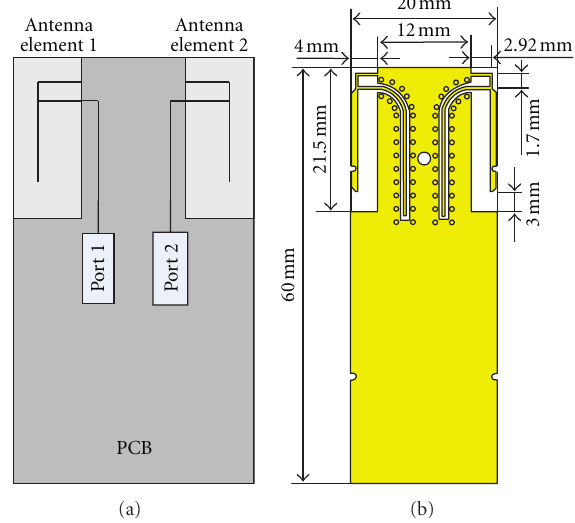
Figure 14: Structure (a) and CST Microwave Studio model (b) of the designed compact two-element MIMO antenna system #3.